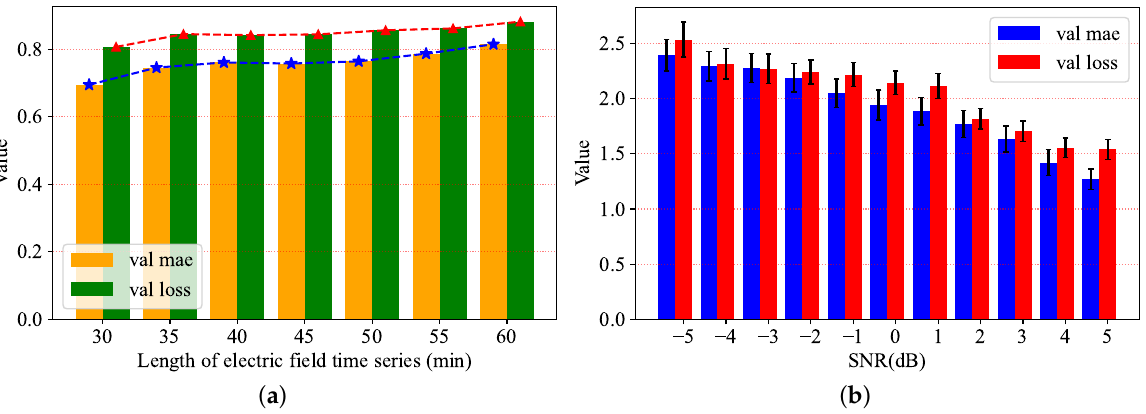
Figure 20. Performance of lightning localization. ( a ) Comparison of experimental results on the prediction of spatial localization by different lengths of electric field time series (the red and blue dashed lines represent the top values of the bar chart, respectively); ( b ) MAE and loss of space positioning module under noisy